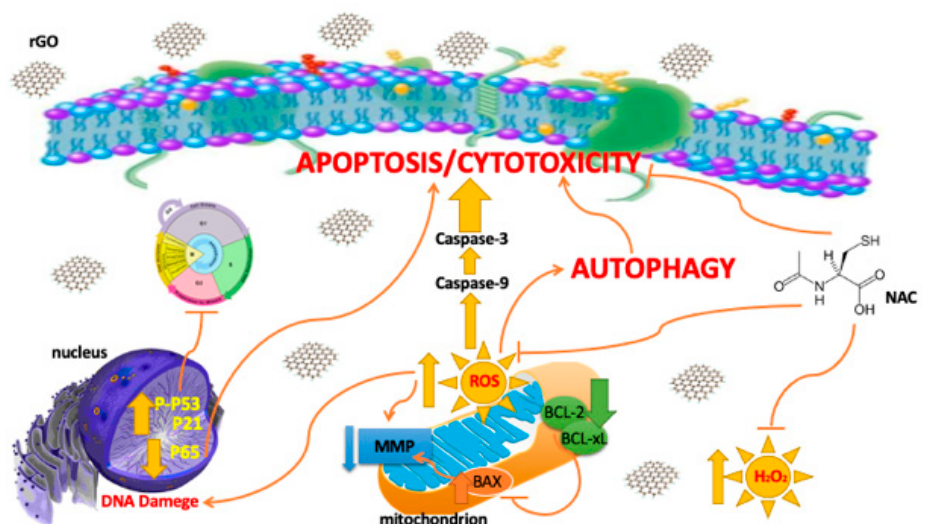
Figure 8. The effect of rGO on cytotoxicity, apoptosis, autophagy, oxidative stress and cell cycle in breast cancer cells. Abbreviation: BAX— Bcl-2-associated X protein; BCL-2—B-cell CLL/lymphoma 2; BCL-xL—B-cell lymphoma-extra-large; MMP—mitochondrial membrane potential; NAC—N-acetylcysteine; rGO—reduced graphene oxide; ROS—reactive oxygen species.